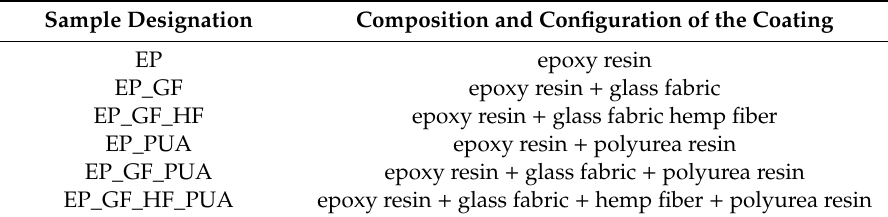
Table 2. Types of applied coatings.